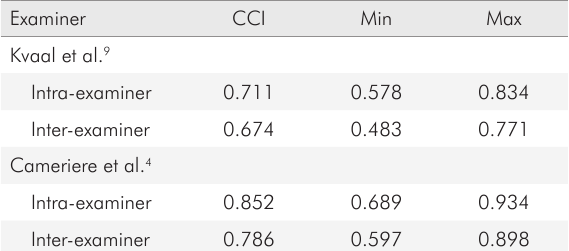
Table 1. Results regarding intra-examiner and inter-examiner agreement for the age estimation methods applied in the study.